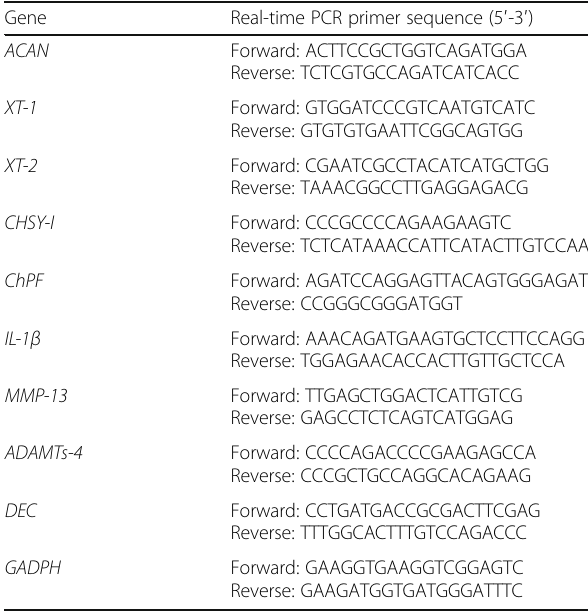
Table 1 Real-Time PCR Primers